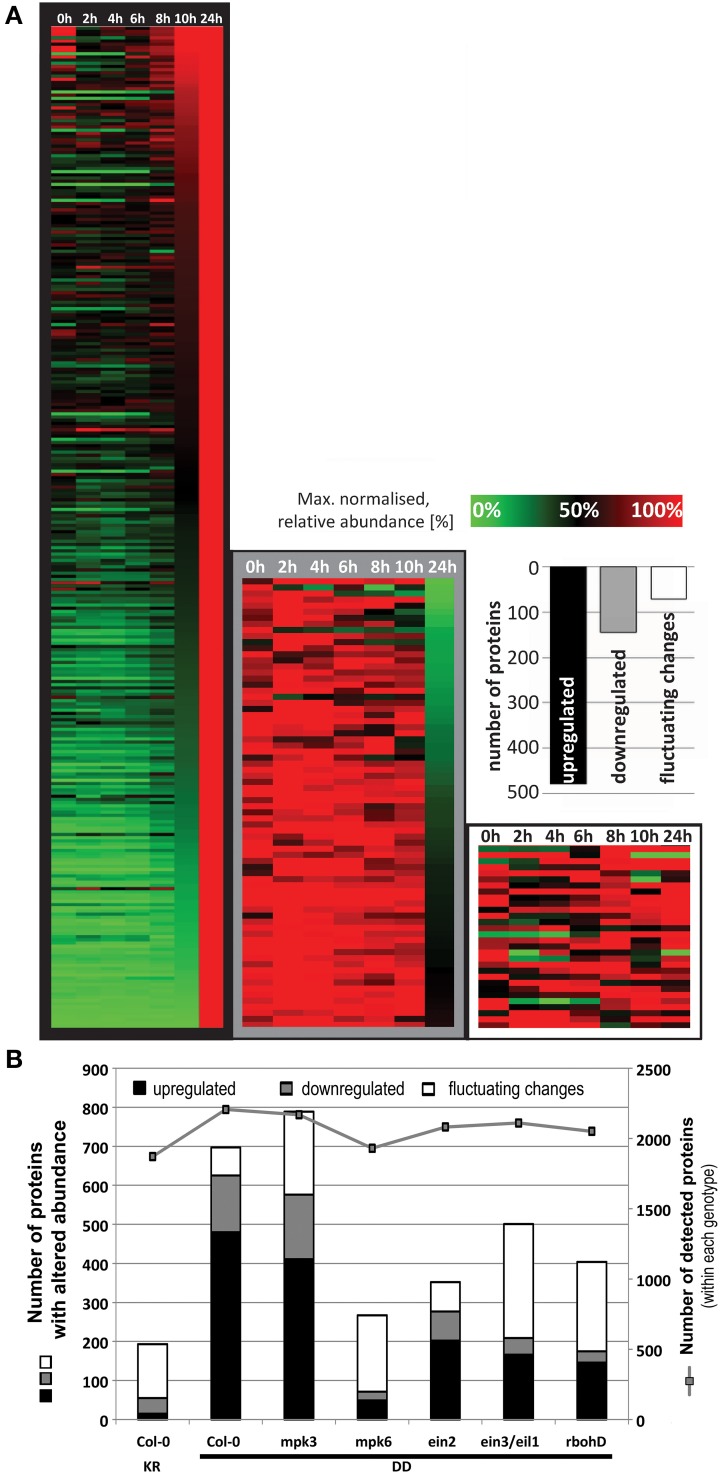
Regulation of global proteome after DEX treatment to induce MPK3/6 activation. (A) The relative abundance was normalized to the maximum value for each protein and a heat map generated by hierarchical clustering according to the MeV (Multiexperiment Viewer) algorithm. This resulted in a cluster of 480 up-regulated proteins, another with 145 down-regulated proteins and a third cluster of 72 proteins showing fluctuating changes. (B) Comparison of the total number of proteins with altered abundance between genotypes. To exclude any bias when comparing genotypes, total numbers of proteins detected within each genotype (right y-axis), which is relatively constant (~2000 throughout all genotypes), are also shown.